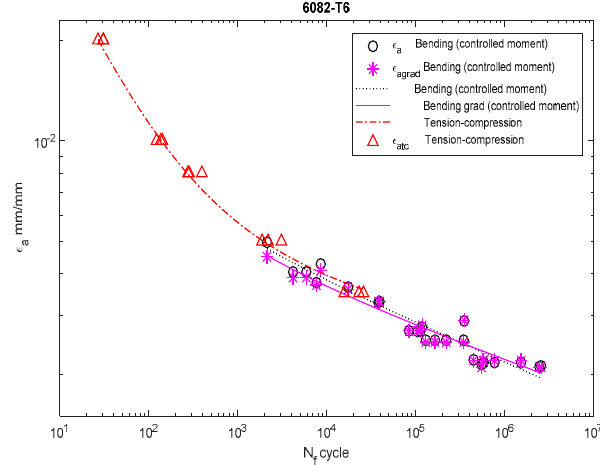
ε = f ( N a f ) for 6082-T4